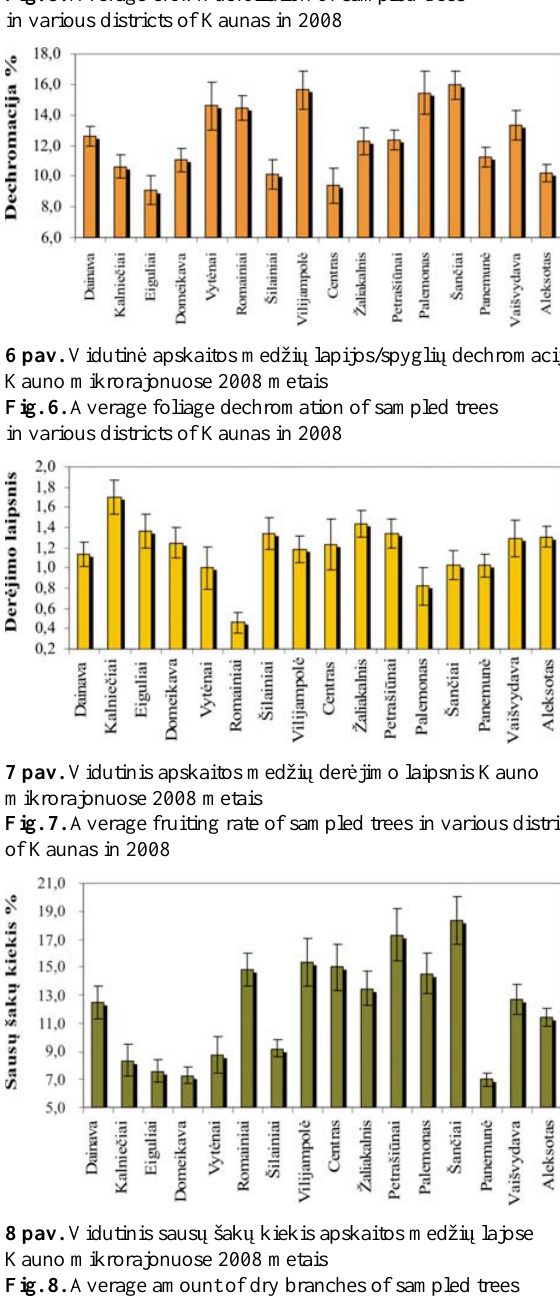
Fig. 8. Average amount of dry branches of sampled trees in various districts of Kaunas in